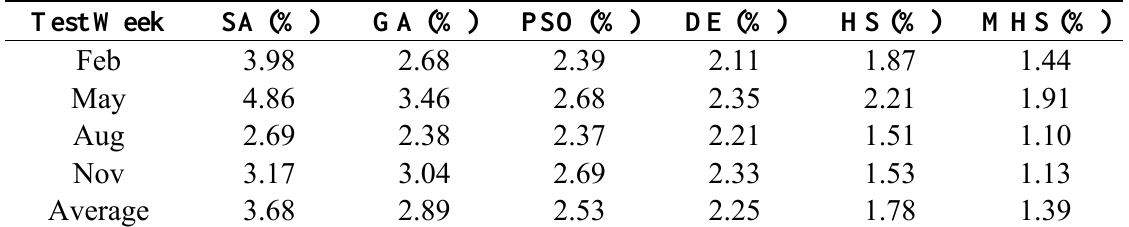
Table 2. Comparison of the proposed MHS with five other stochastic search techniques for day-ahead STLF of the PJM test case in the four test weeks of year 2009 (the reported results are in terms of MAPE criterion).